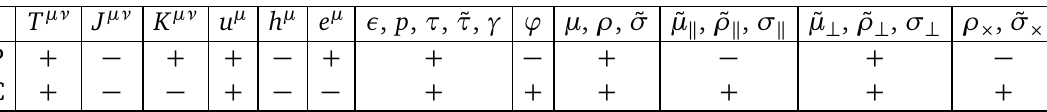
Table 2: Charges under discrete symmetries for 1-form